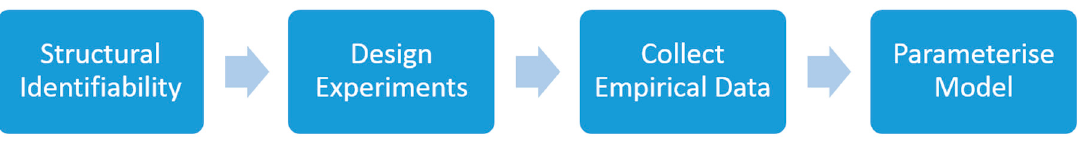
Figure 4. Recommended modelling flow diagram.